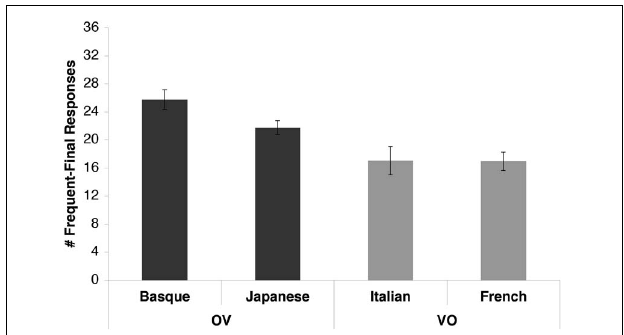
FIGURE 3 | Basque, Japanese, Italian, and French speakers’ word order preferences. The y-axis shows the number of IF responses given by the groups (out of a total of 36 test trials). Errors bars represent the standard errors of the mean. OV languages are shown in dark gray; VO languages in light